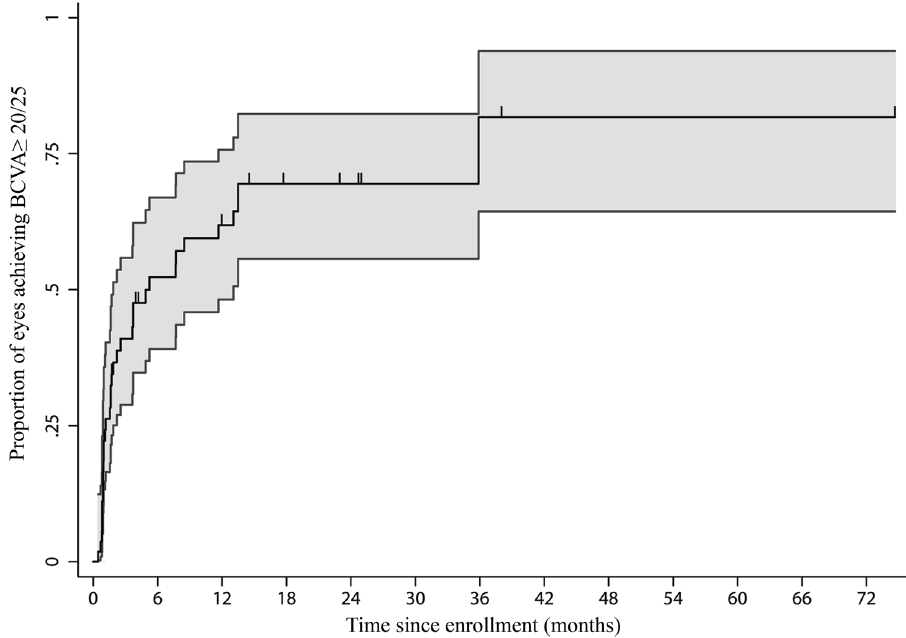
Figure 3. Kaplan–Meier estimates of the overall cumulative probability of best corrected visual acuity (BCVA) improvement to ≥ 20/25 among a total of 54 eyes with baseline BCVA of < 20/25. Shaded areas denote 95% confidence